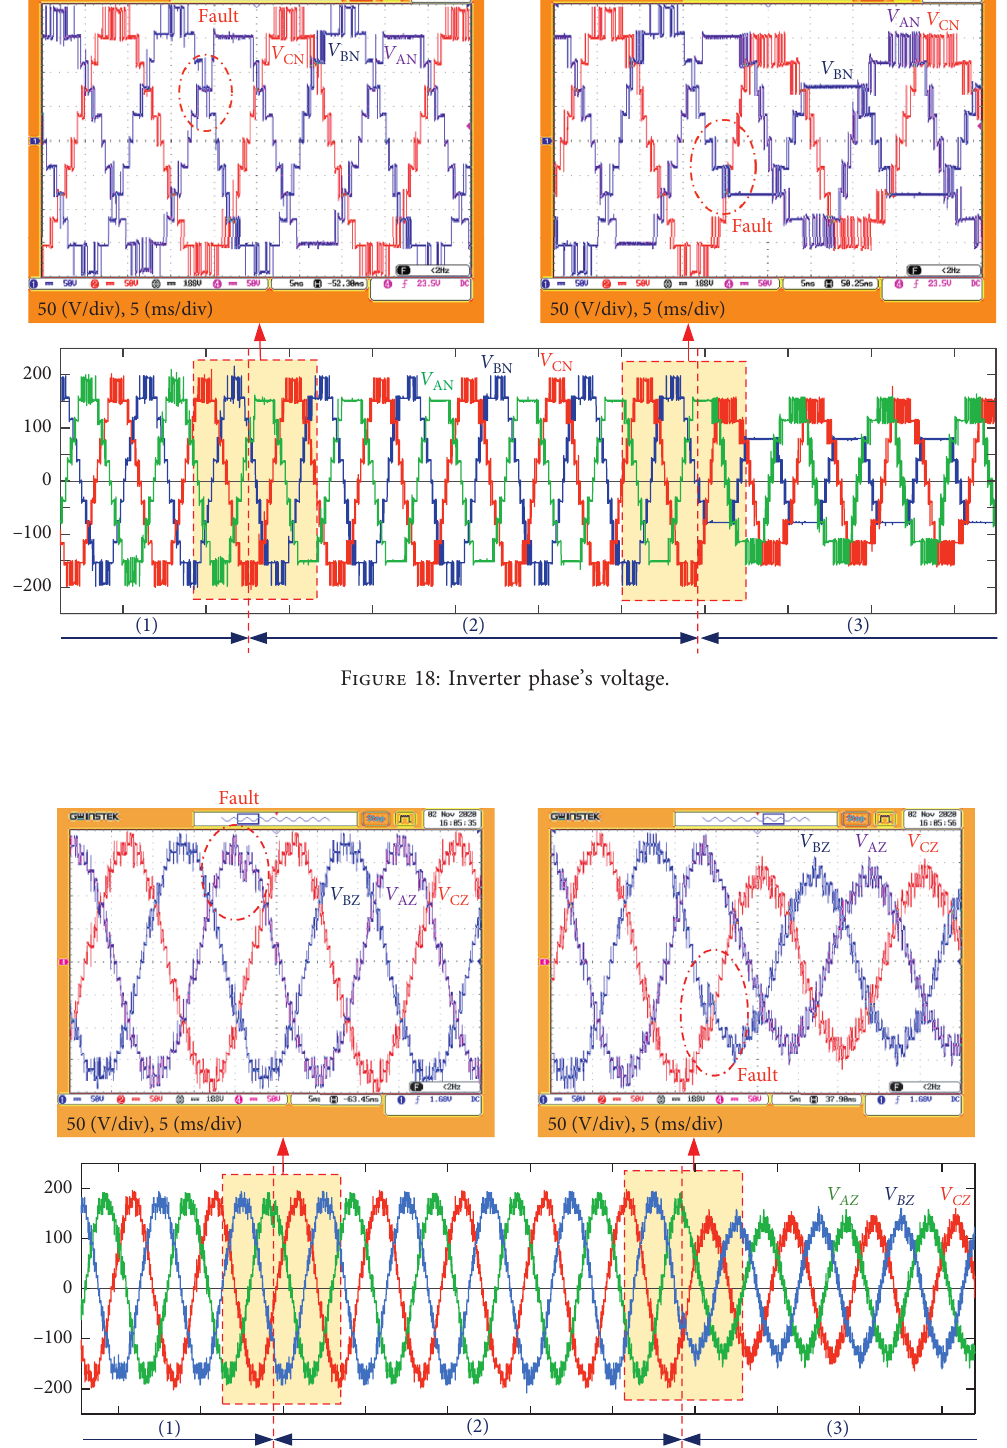
Figure 19: Inverter load’s voltage.